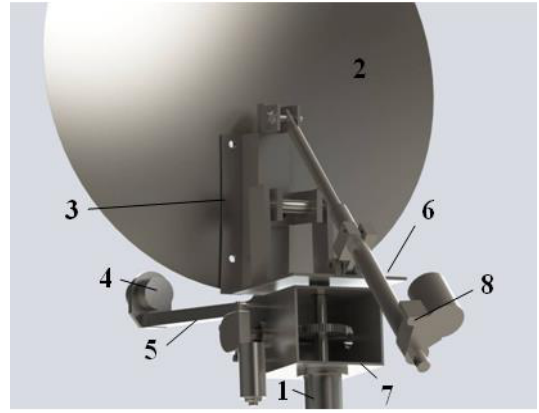
Figure 9. Solar tracker